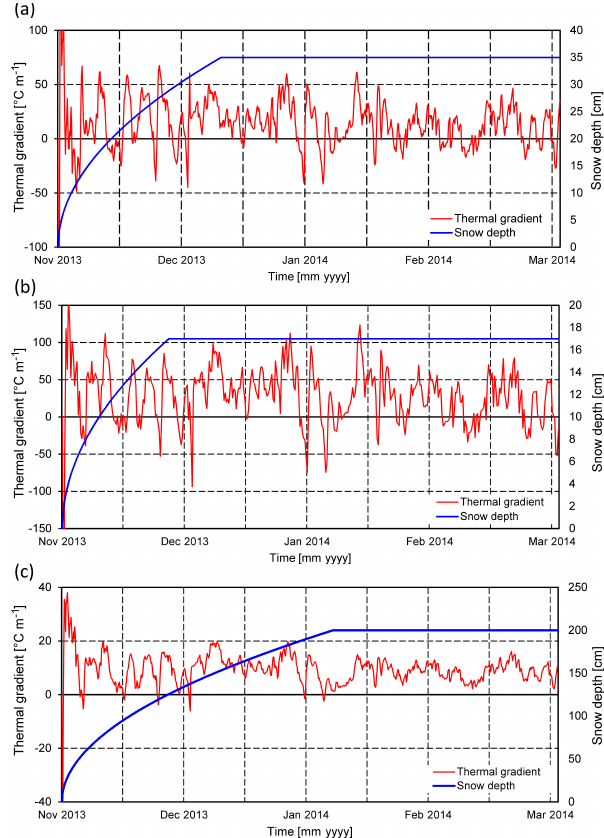
Figure 6. Temperature gradient in the snowpack calculated through the winter for the three sites of snow pits presented in Fig. 4: (a) snow pit 1, (b) snow pit 2, and (c) snow pit 3. The postulated snow depths evolution used to calculate the gradient are also